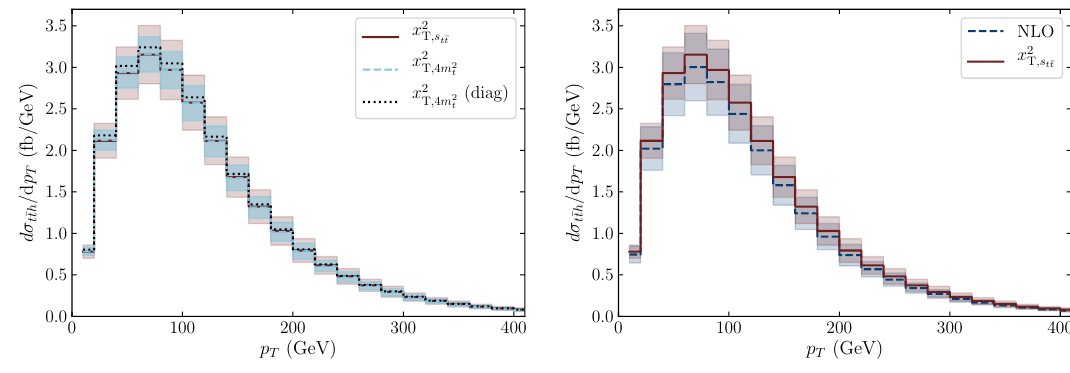
Figure 8 . Left: transverse-momentum distribution of the matched resummed results using x 2 T, 4 m 2 t with/without the approximated soft-anomalous dimension matrix (black dotted and light-blue dashed) and x 2 (red solid). The colored bands indicate the total scale uncertainty band, ob- T,s t ¯ t tained as before (eq. (5.2) with Q → p and µ 0 ∈ µ , µ , µ , µ ). The scale uncertainty T M H T high low band for x 2 (diag) is not shown. Right: transverse-momentum distribution of the NLO result T, 4 m 2 t (dark-blue dashed) and the matched result for x 2 T,s t ¯ t